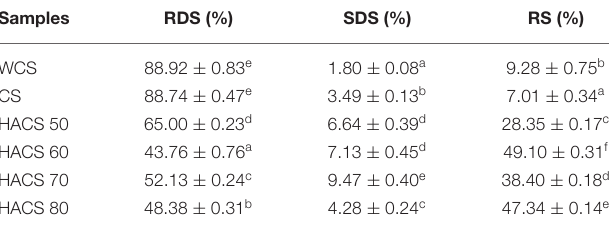
TABLE 1 | RDS, SDS, RS content of corn starch with different amylose content. Samples